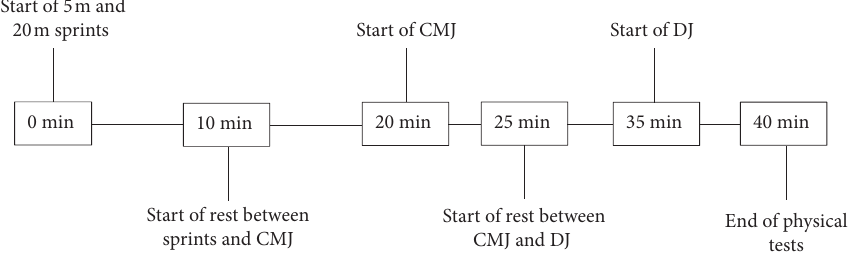
Figure 2: Breakdown of timeframes of test conditions during the study.